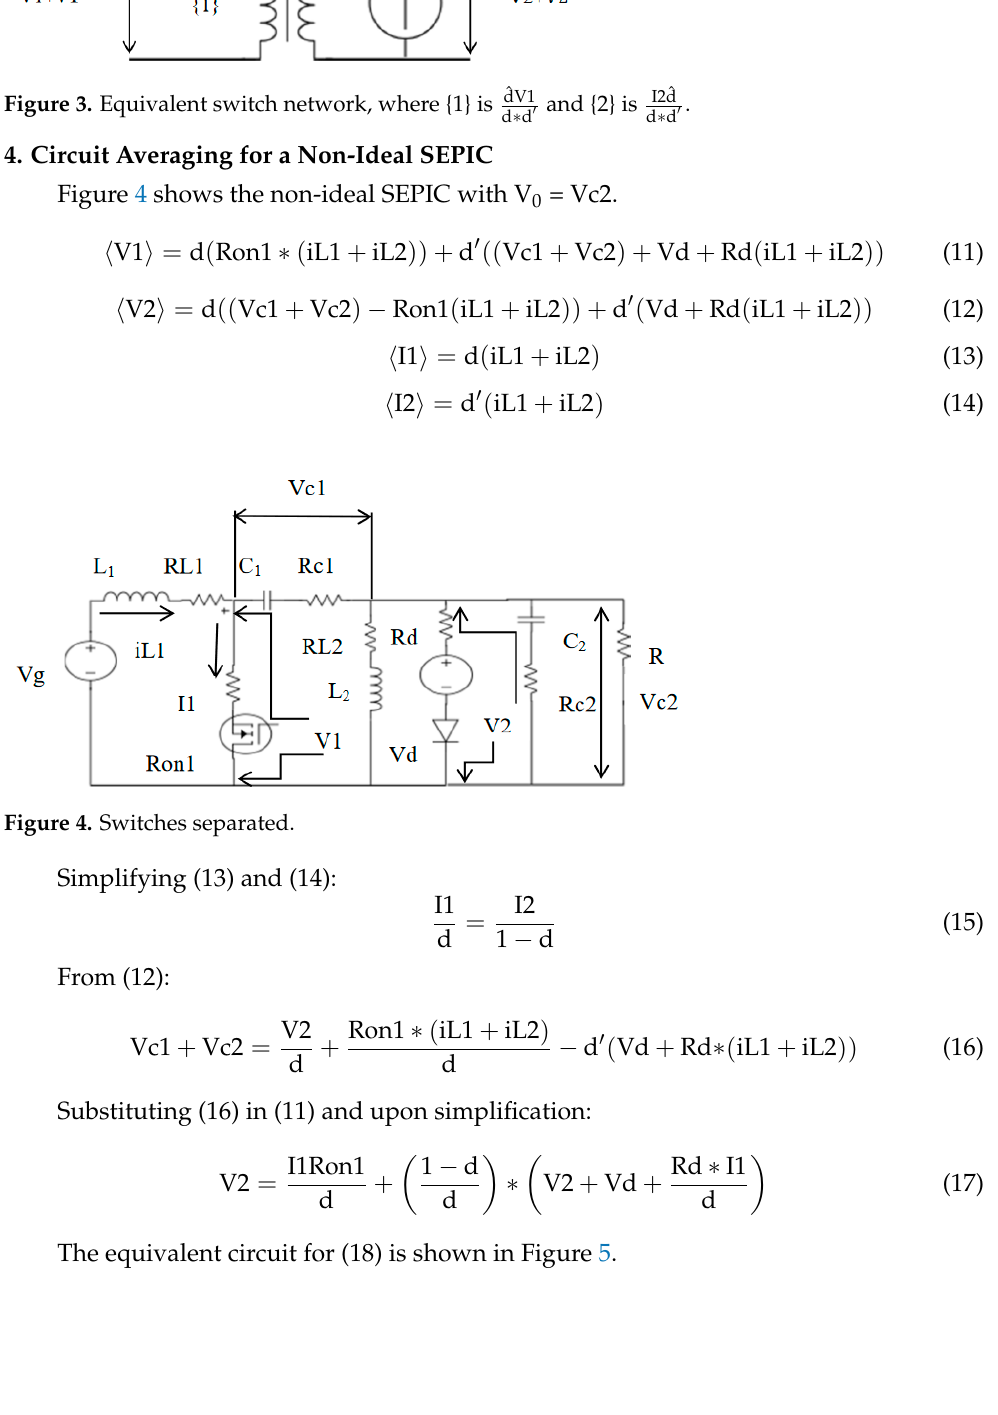
Figure 5. Equivalent switch circuit.